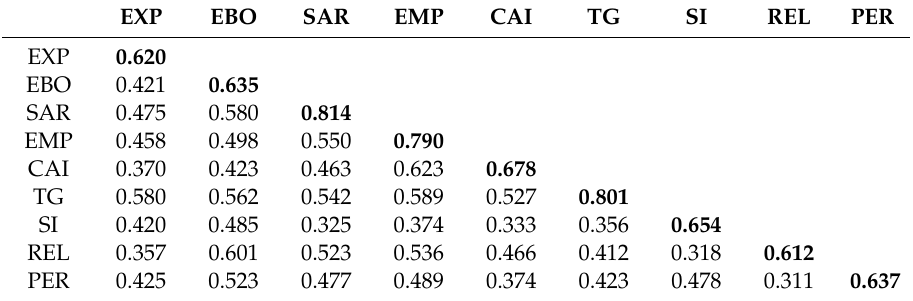
Table 3. Results of the discriminant validity analysis from